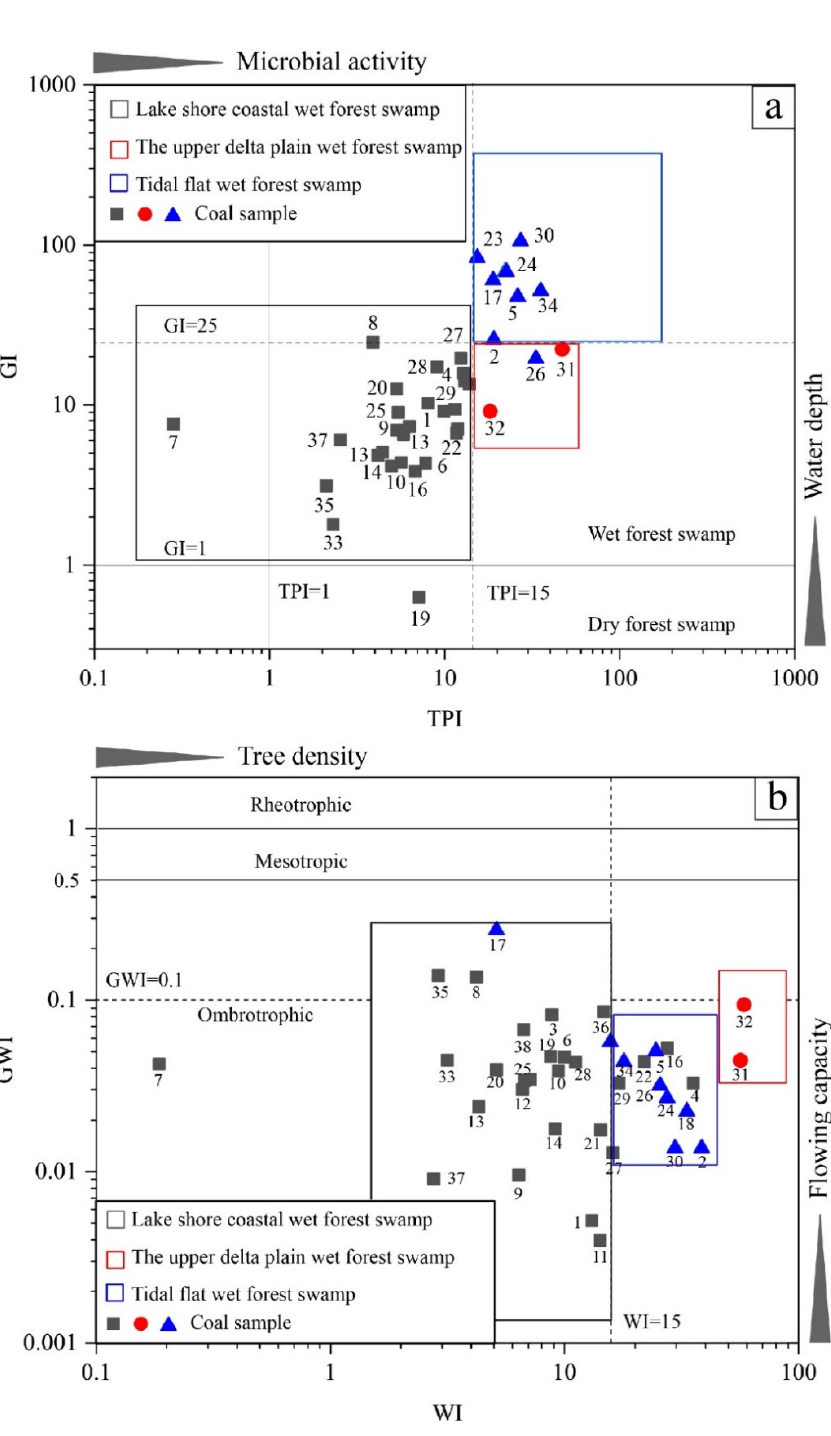
Figure 8. Coal facies interpretation from Sangjiang-Muling coal-bearing basins. ( a ) Gelification index–tissue preservation index (GI–TPI), ( b ) groundwater index–wood index (GWI–WI).